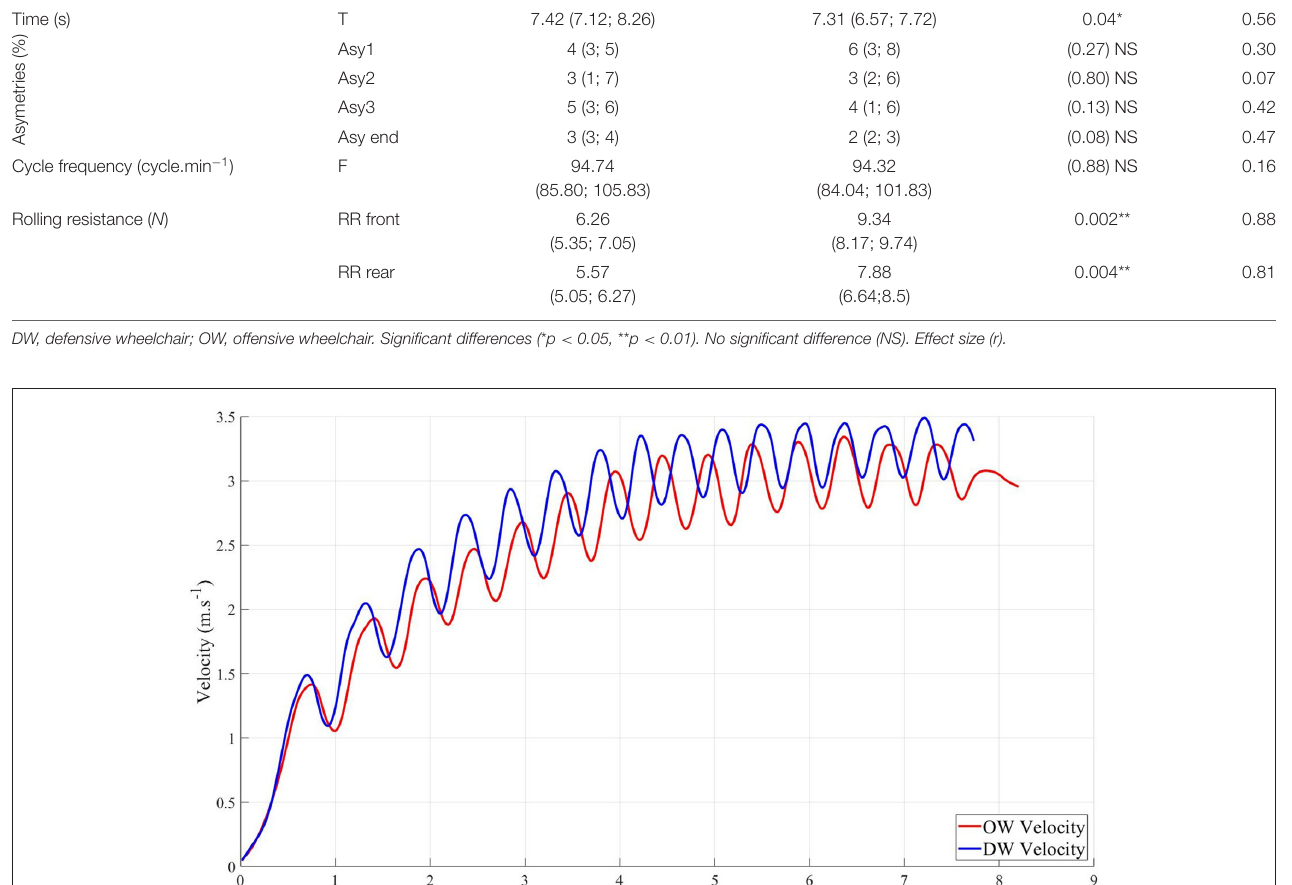
OW and a DW on kinematic variables during a straight-line sprint. To our knowledge, this is the first study to compare the impact of wheelchair type on kinematic variables in wheelchair rugby. Our results showed that all kinematic performance variables were higher for the DW than the OW. In addition, no difference in terms of asymmetry was found between both wheelchairs. However, the results of this study confirmed our third hypothesis that the rolling resistance would be greater with the